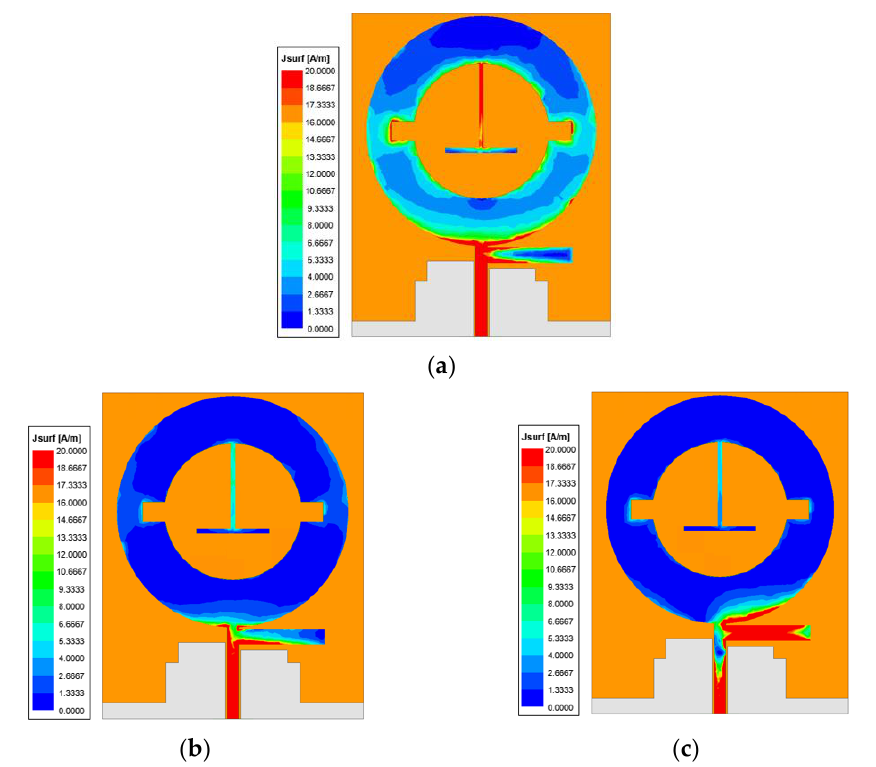
Figure 4. Current distribution of the proposed antenna; ( a ) current distribution at 2.4 GHz; ( b ) current distribution at 3.5 GHz; ( c ) current distribution at 7.5 GHz.